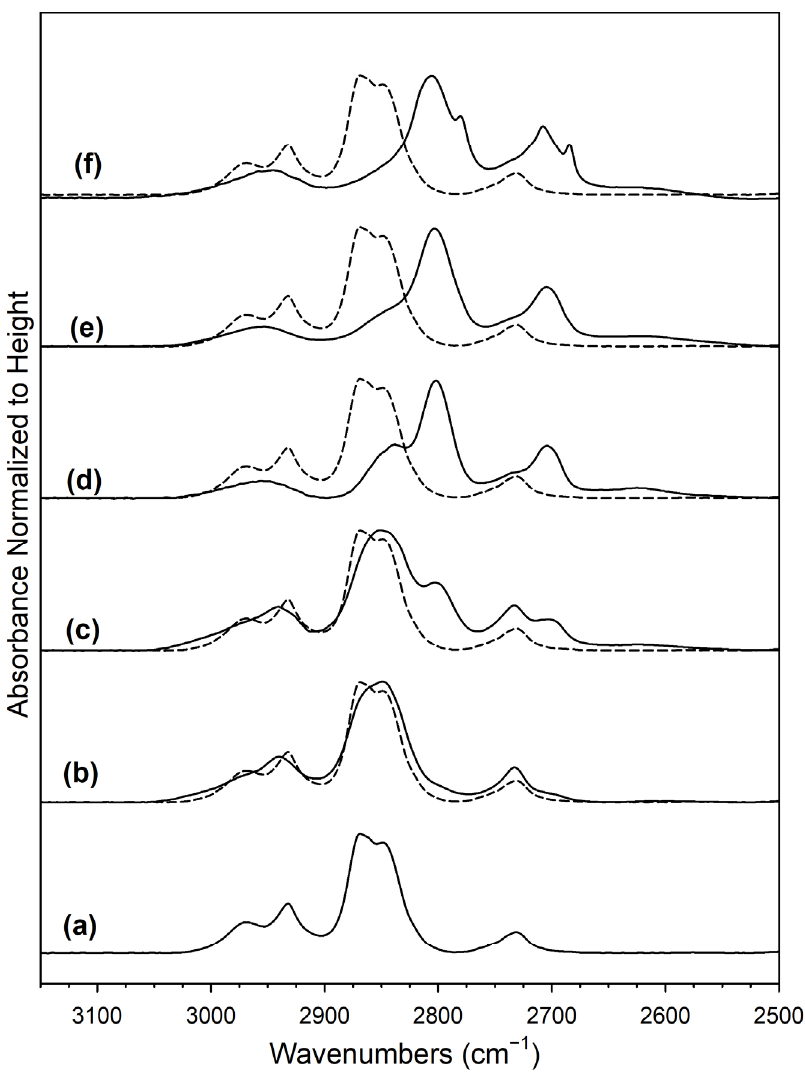
Figure 8. ν (CH) stretching region of DRIFTS of steam reforming of adsorbed formaldehyde at 100 °C for ( a ) 2%Pt/m-ZrO 2 , and the same with ( b ) 0.5%Na, ( c ) 1%Na, ( d ) 1.8%Na, ( e ) 2.5%Na, and ( f ) 5%Na.